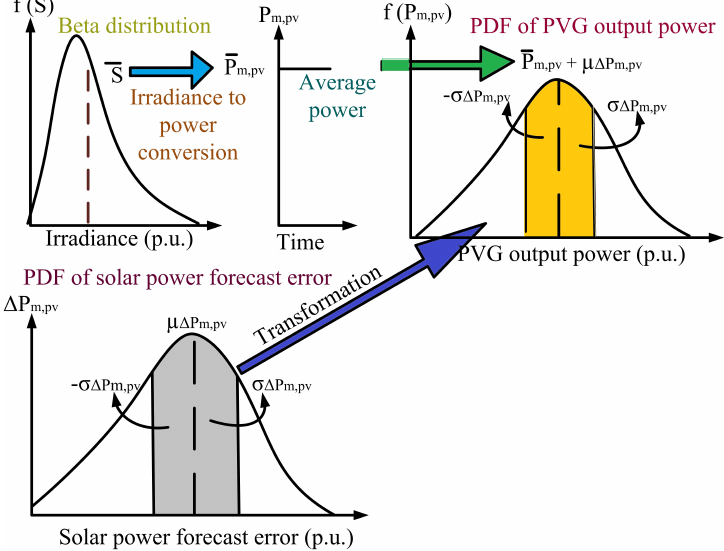
Figure 3. Graphical illustration of PDF computation of